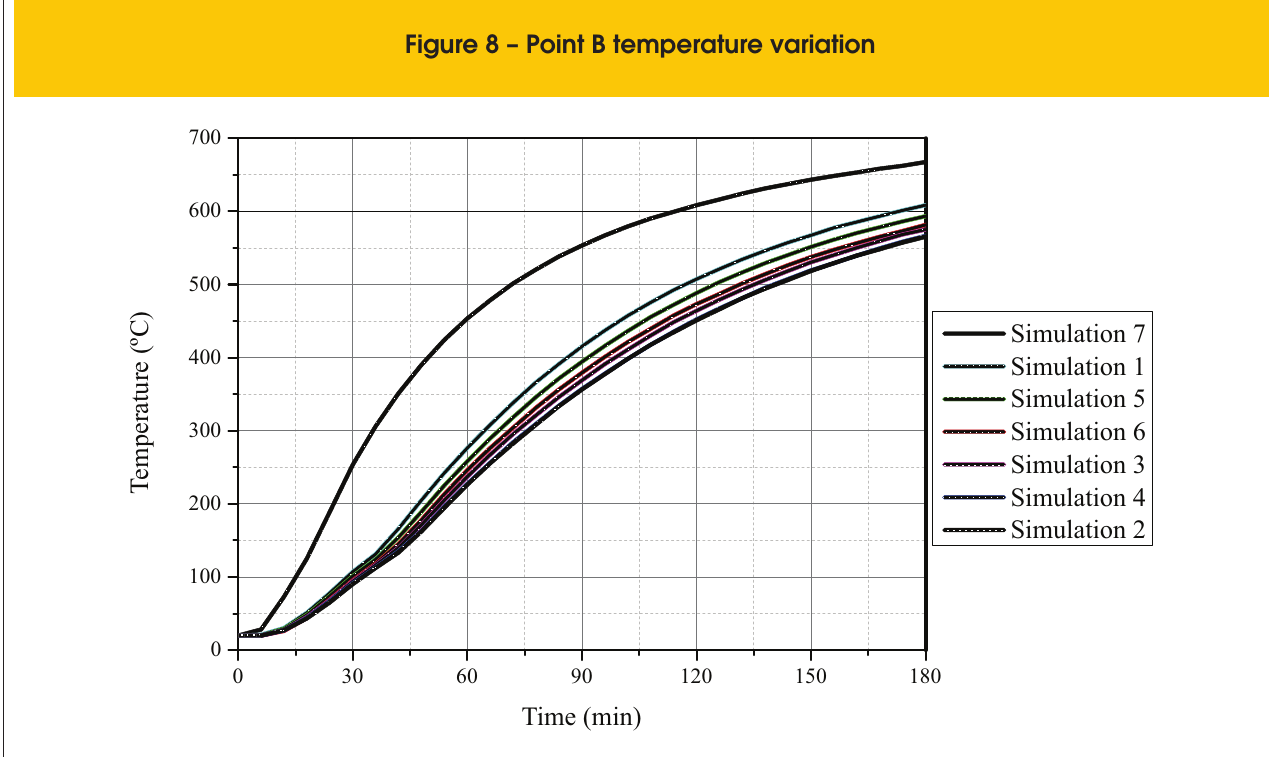
Figure 8 – Point B temperature